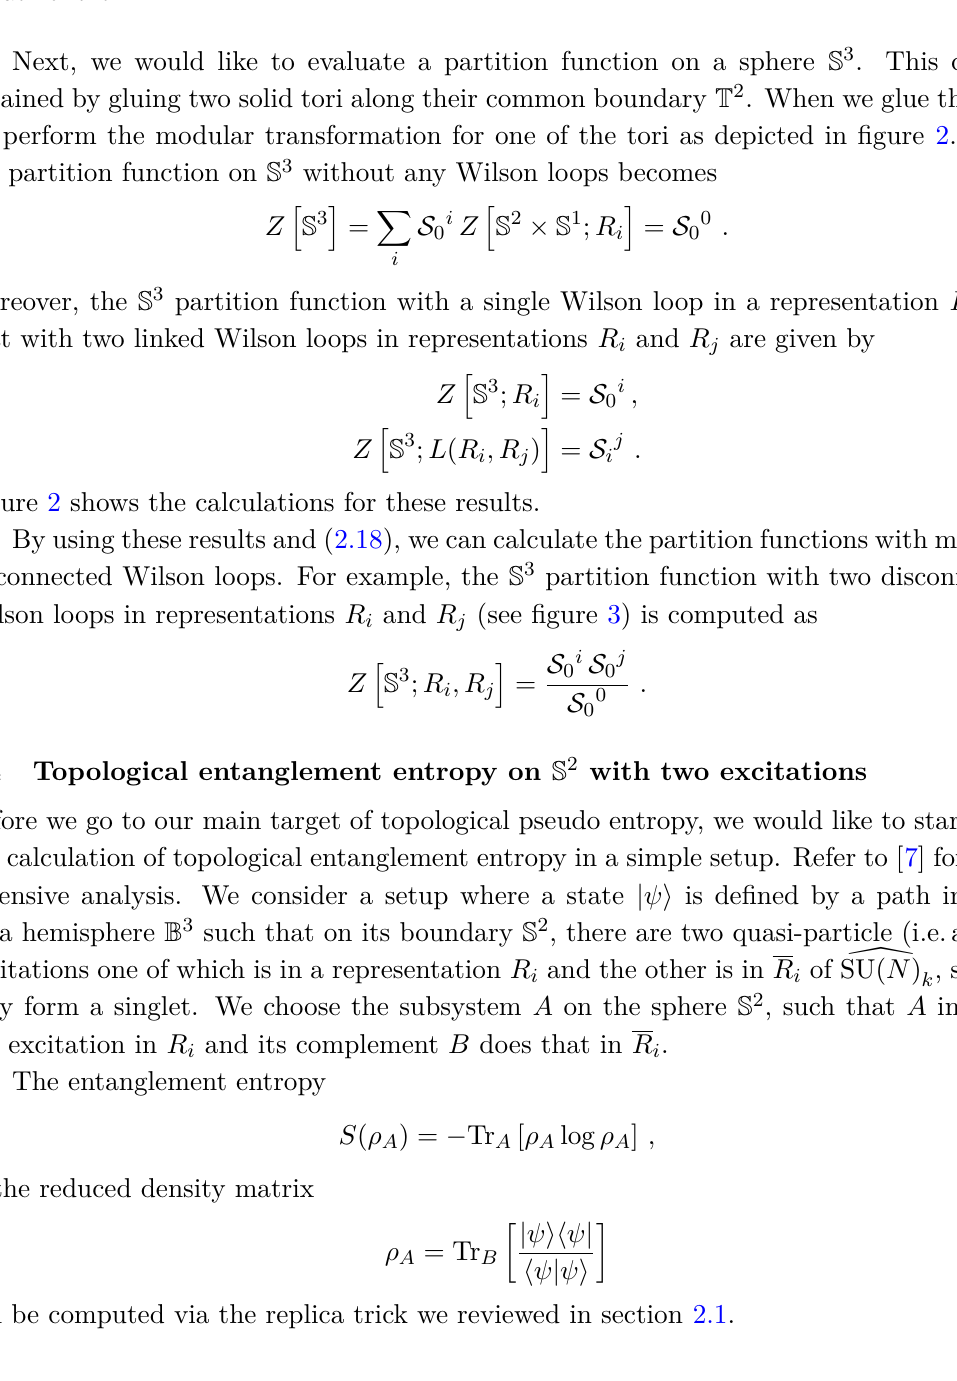
Figure 1 . A manifold can be decomposed into two by cutting it a half and attaching hemispheres to each of